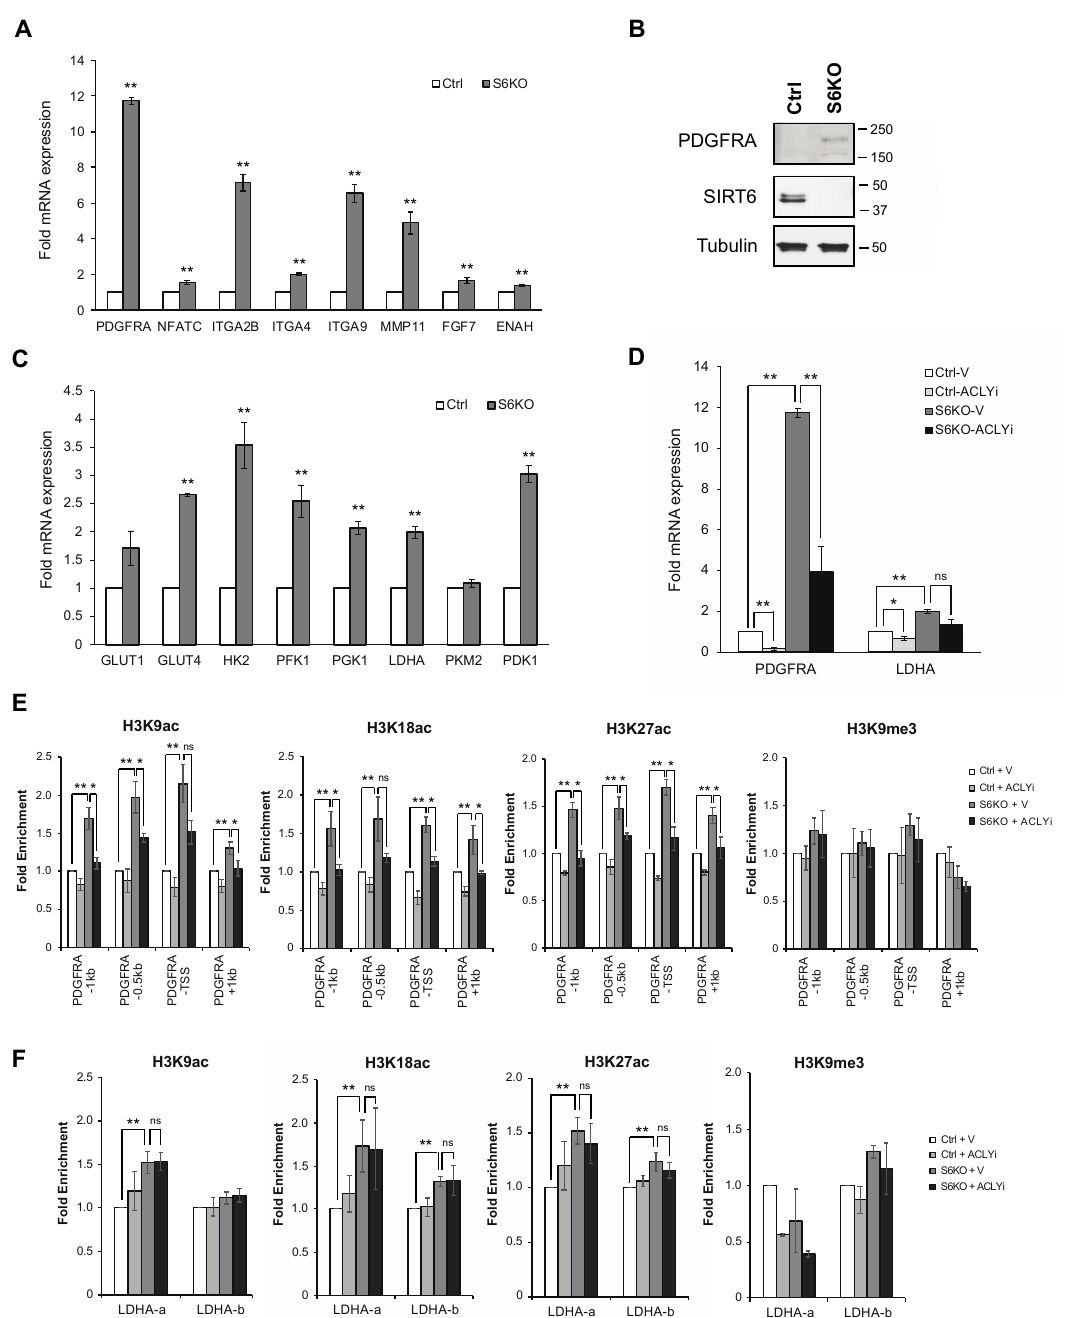
Figure 2. ACLY-dependent up-regulation of Acetyl-CoA responsive genes in SIRT6 deficient U2OS cells. ( A ). Expression of acetyl-CoA responsive genes in control and SIRT6 KO cells normalized to GAPDH (Mean ± SEM of four independent experiments, ** p < 0.01, two-tailed Student’s t -test). ( B ). Increased PDGFRA protein levels in SIRT6 deficient cells compared to control cells. ( C ). Expression of glycolytic genes in control and SIRT6 KO cells normalized to GAPDH (Mean ± SEM of three independent experiments, ** p < 0.01, two-tailed Student’s t -test). ( D ). Increased expression of PDGFRA but not LDHA in SIRT6 KO cells is attenuated by ACLY inhibitor (ACLYi, 50 uM; 24 h). Data are normalized to GAPDH and show Mean ± SEM of four independent experiments, * p < 0.05, ** p < 0.01, ns: not significant, two-tailed Student’s t -test. ( E ). Increased H3 acetylation marks on PDGFRA promoter regions by ChIP-qPCR, attenuated by ACLY inhibitor (Mean ± SEM of three independent experiments, * p < 0.05, ** p < 0.01, ns: not significant, two-tailed Student’s t -test). ( F ). Increased H3 acetylation marks on LDHA gene promoter regions by ChIP-qPCR, independent of ACLY inhibition (Mean ± SEM of three independent experiments, ** p < 0.01, ns: not significant, two-tailed Student’s t